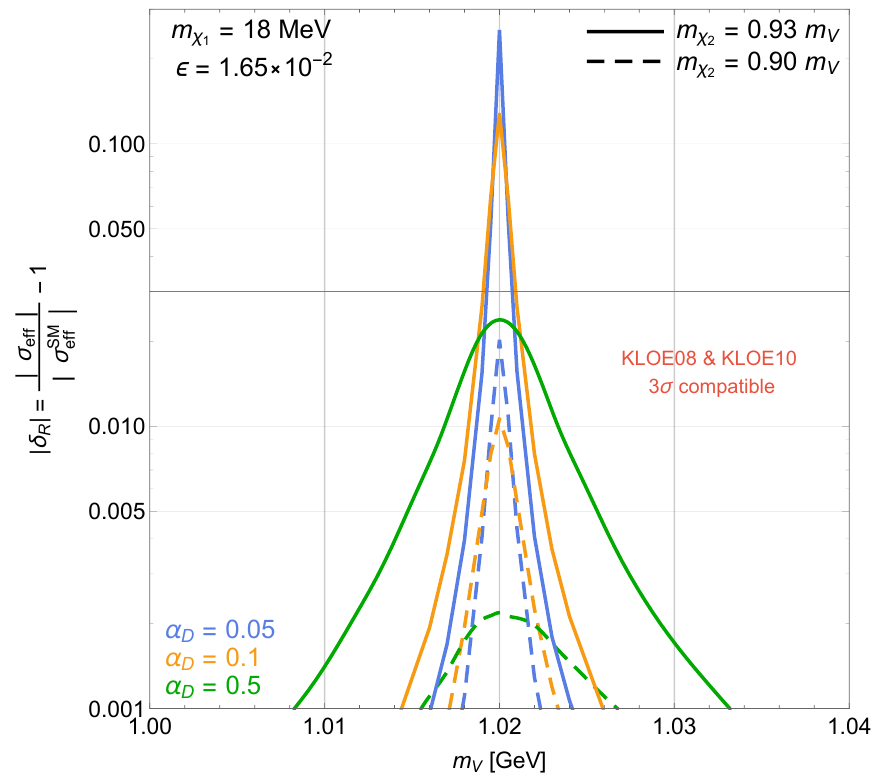
Figure 2 . Relative enhancement δ R of the inferred Bhabha cross section as a function of m V for m = 0 . 93 m (solid curves) and m = 0 . 9 m (dashed curves), and α χ 2 V χ 2 V (orange) and 0 . 5 (green). In this plot m = 18 MeV and ε = 1 . 65 × 10 − 2 . Below the red horizontal χ 1 line all the KLOE measurements are consistent at a 3 σ